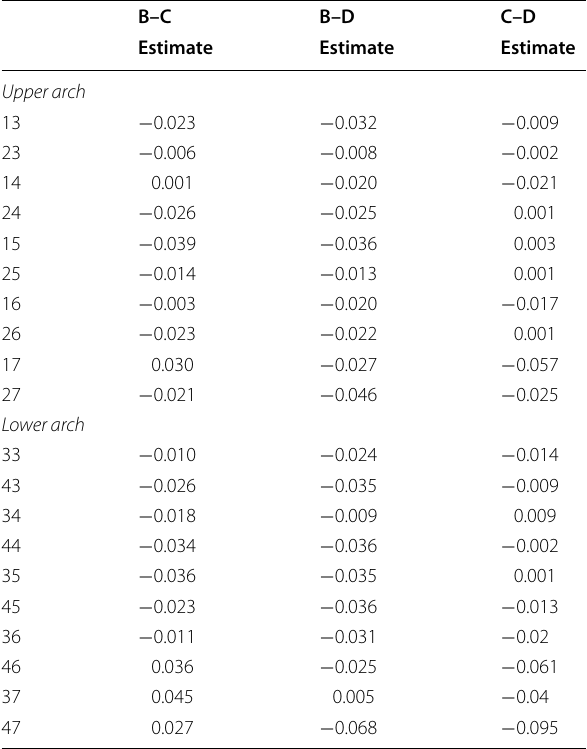
elements, while in the cross section 4.4–3.4 of unit Trios yellow/red occlusal surfaces are observed which confirm the average variation of the difference in inter-arch dis- tance in the comparison between units A - D approxi- mately 60 µm greater than the A - B differences (Fig. 3).